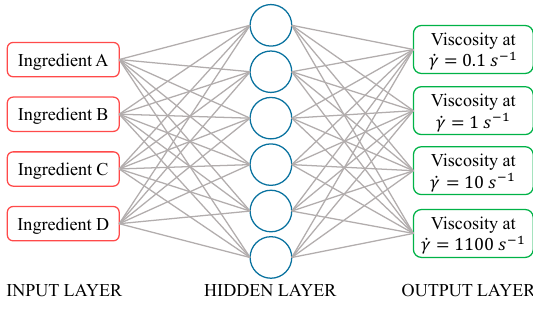
Figure 4. Structure of the neural network used for the function f NN in the continuous Hammerstein model. Table 1. Range of the ingredients’ mass fraction.